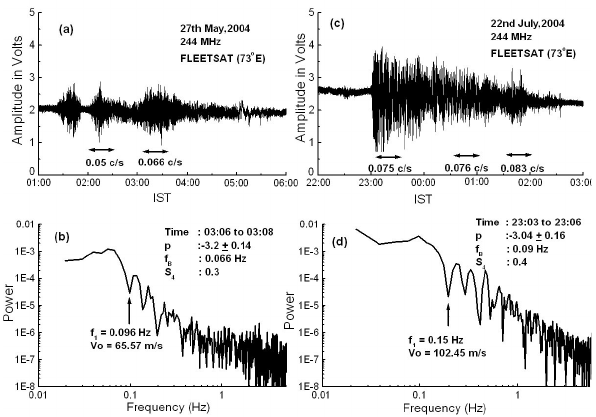
Fig. 2. (a) Typical BSS type scintillations record on 27 May 2004. (b) Power spectrum of scintillations of the above record (Fig. 2a) showing Fresnel oscillations. (c) Typical BSS type scintillations record on 22 July 2004. (d) Power spectrum of scintillations of the above record (Fig. 2c) showing Fresnel